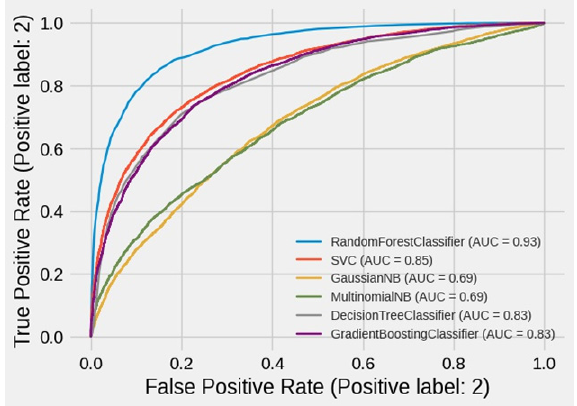
Figure 14. ROC curve for results of ML algorithms.